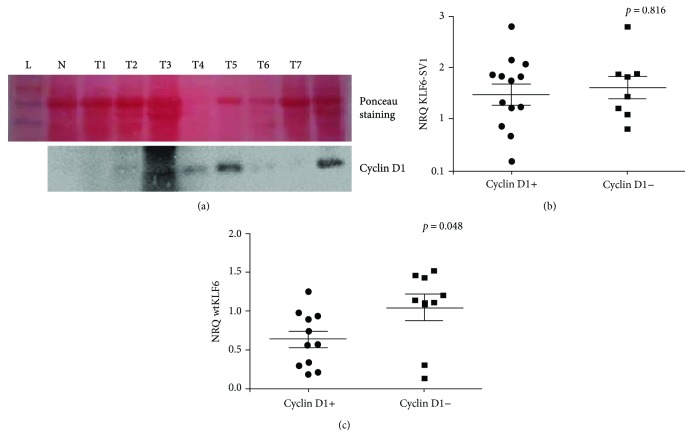
Analysis of cyclin D1 expression and correlation with wtKLF6 and KLF6-SV1. Total proteins extracted from nontumor (N) and tumor samples (T1–T8) were analyzed by Western blot using a monoclonal anti-cyclin D1 antibody followed by HRP-conjugated anti-rabbit IgG, and the signal was revealed by the ECL plus kit (Amersham Biosciences). Ponceau staining was represented in the upper part of (a). Association between the cyclin D1 and the expression levels of KLF6-SV1 (b) and wtKLF6 (c) in tumor tissues. Cyclin D1+ (value densitometry > 1) and cyclin D1− (value densitometry < 1).